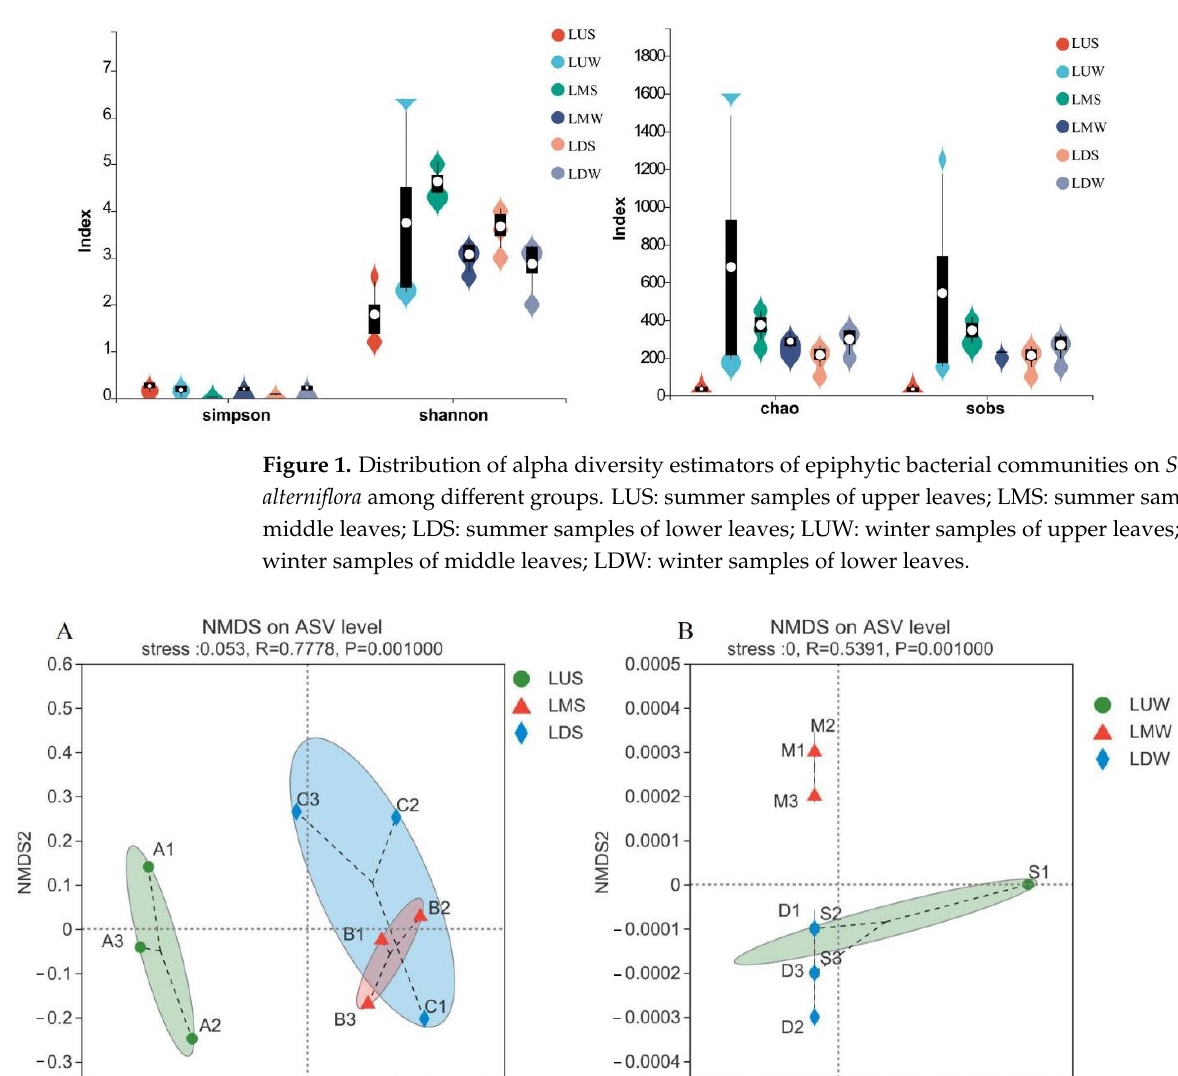
Figure 1. Distribution of alpha diversity estimators of epiphytic bacterial communities on Spartina alterniflora among different groups. LUS: summer samples of upper leaves; LMS: summer samples of middle leaves; LDS: summer samples of lower leaves; LUW: winter samples of upper leaves; LMW: winter samples of middle leaves; LDW: winter samples of lower leaves.